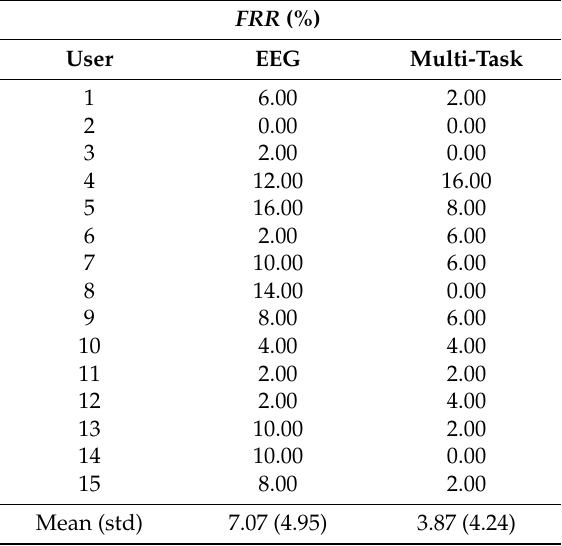
Table 4. Permanence test results of each